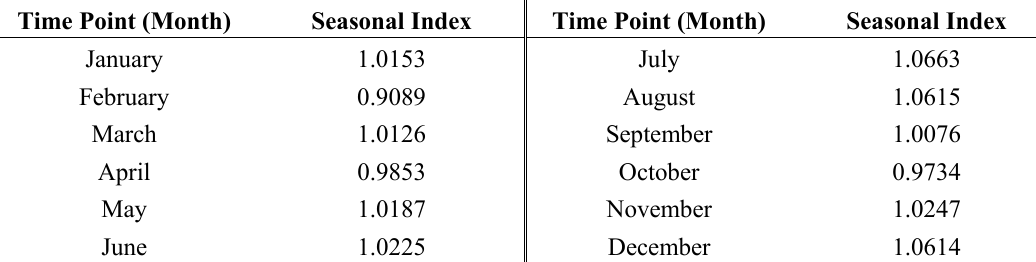
Table 5. The seasonal indexes for each time point (month).